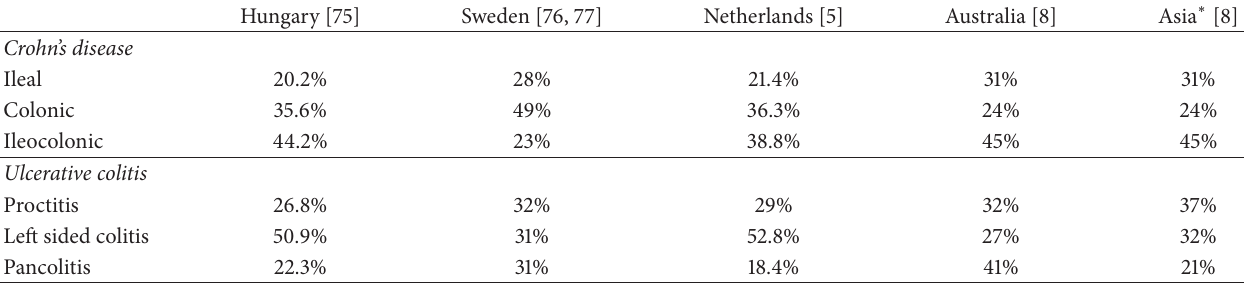
Table 2: Disease location at diagnosis as per Montreal